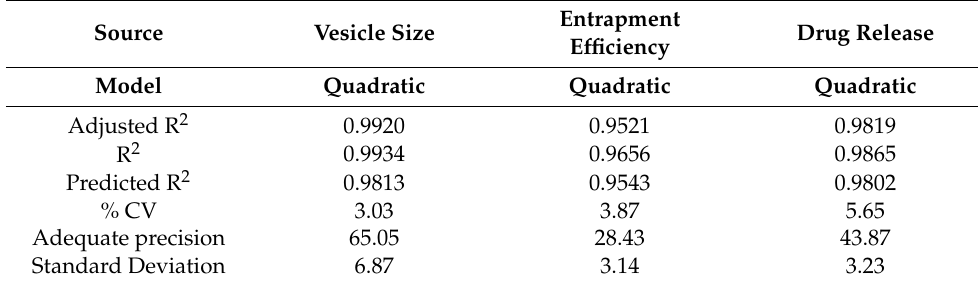
Table 3. Model statistical summary of quadratic mode for vesicle size, EE and